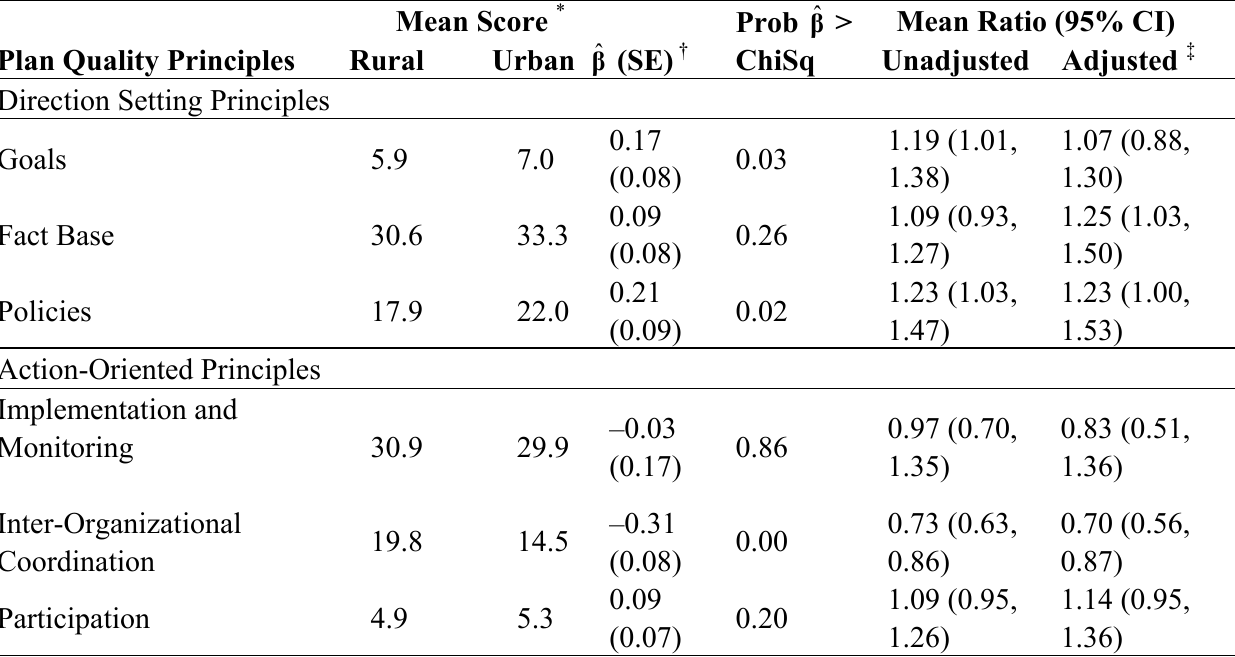
Table 2. Mean score, beta coefficients, standard errors and unadjusted and adjusted mean ratios (95% confidence intervals) for indicators of plan quality in urban versus rural counties from 57 Counties in the southeastern